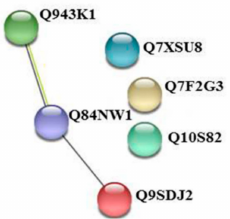
Figure 5. Interaction map of priming-regulated proteins. Network was built by using STRING 10.5 software, at 0.4 confidence level. Prediction was performed on proteins listed in Table